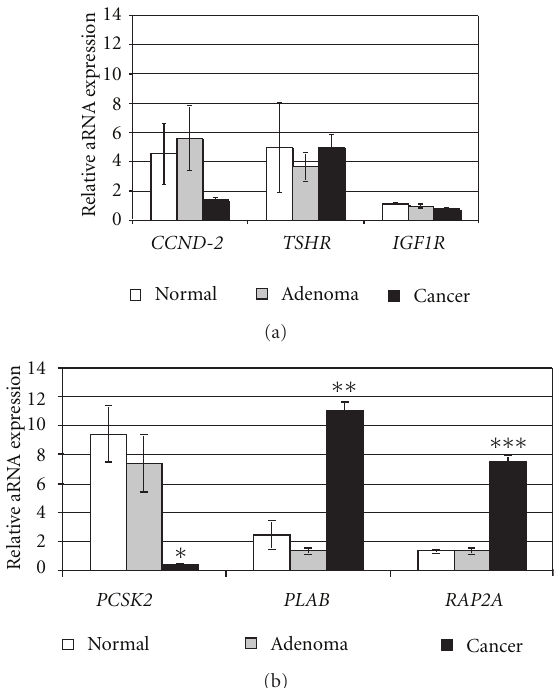
Figure 1: Evaluation of CCND2, TSHR, IGF-1R (a) and PCSK2, PLAB, RAP2A (b) mRNA expression by Q-RT-PCR in tissue sam- ples from the human thyroid (normal, benign, cancer). All PCR reactions were performed in duplicates with at least three repeats. Mean of normalized expression level of mRNA in each analyzed group ( n = 10) are shown. Bar, SEM. ∗ P = 2 . 81 E − 2, ∗∗ P = 9 . 81 E − 12, and ∗∗∗ P = 9 . 13 E −